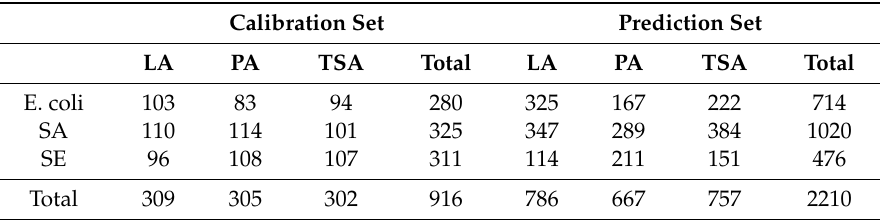
Table 6. Number of samples in the calibration and prediction